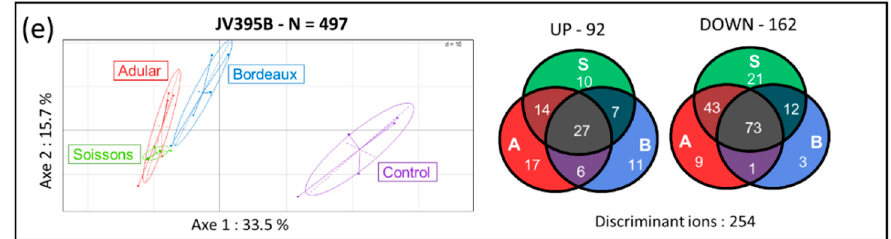
Figure 2. Principal component analysis obtained from LC − HRMS profiles of Pseudomonas strains. The LC-HRMS profiles are those of Pseudomonas protegens CHA0 ( a ), Pseudomonas kilonensis F113 ( b ), Pseudomonas koreensis JV222 ( c ), Pseudomonas chlororaphis JV497 ( d ) and JV395B ( e ) cultivated with wheat root extracts. All principal component analyses were associated with Venn diagrams representing proportions of metabolite ions of Pseudomonas significantly over and less produced in the presence of root extracts of Adular (A), Soissons (S) or Bordeaux (B) genotypes against control ( p ≤ 0.05; a Wilcoxon nonparametric test corrected for false discovery; n = 5 replicates). The principal component analysis obtained from the extracts of CHA0 under the influence of wheat extract at 25 (C1) and 50 µ g/mL (C2) highlighted the concentration-dependent effects of the wheat extracts ( a ). The correlation circle associated with the principal component analysis for the CHA0 strain displays the metabolite ions involved in the separation of samples ( a